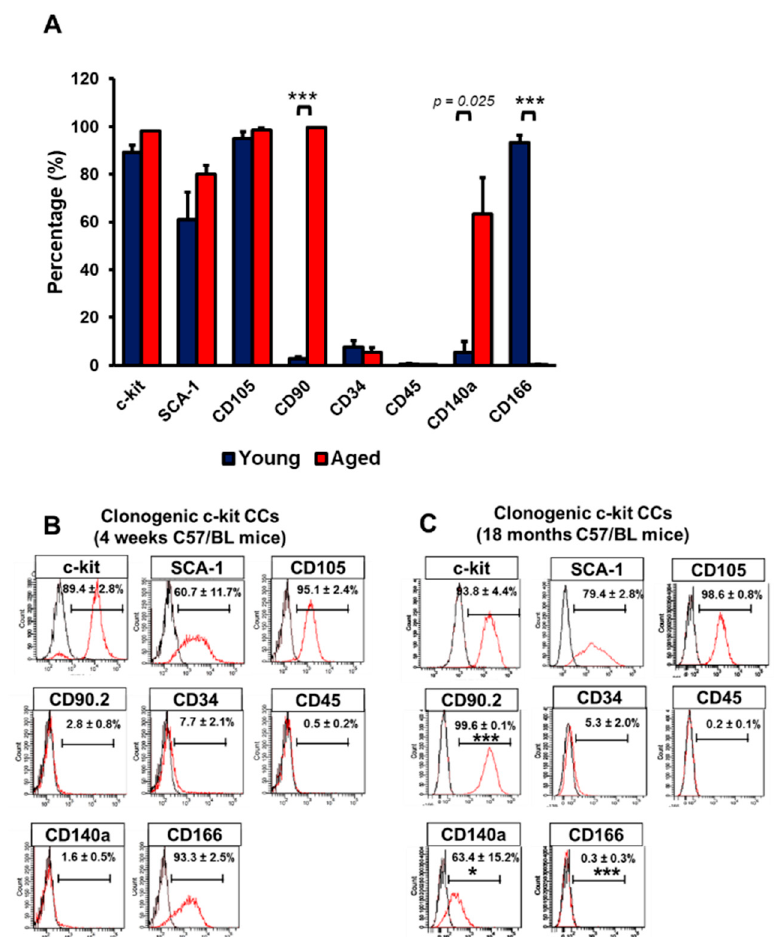
Figure 1. Clonogenic cardiac c-kit cells (CCs) can be derived from single cells. Clonogenic CCs were cultured from single cell for 14 days. ( A ) Graph showing surface marker expressions on c-kit-expressing CCs isolated from young (1-month) and aged (18-months) C57 / BL6N mice. ( B ) Surface marker expression of clonogenic ( B ) young and ( C ) aged CCs. All data are mean ± SEM. * p < 0.05; *** p < 0.001 vs. Clonogenic yCCs ( n = 3). [Abbreviation: CD34, hematopoietic marker; CD45, mast cells; CD90, thymocyte differentiation antigen; CD105, endoglin; c-kit, stem cell growth factor receptor; CD140a, PDGFR α ; Sca-1, stem cell antigen; CD166, ALCAM].